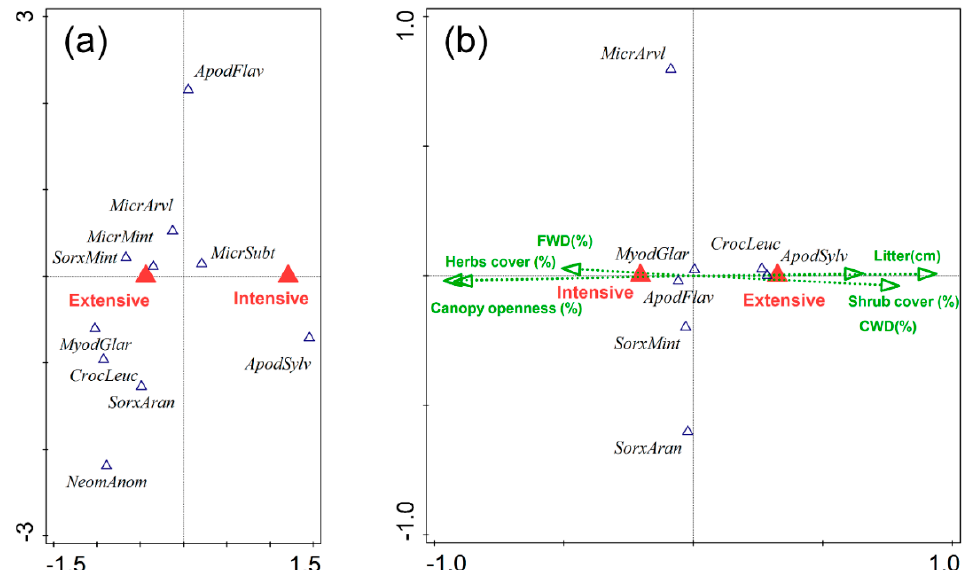
Figure 2. Partial canonical correspondence analysis biplot with the study month as a covariable showing ( a ) the change in small mammal assemblages at intensive (mechanical soil preparation after clearcutting) and extensive (without soil preparation) study plots; ( b ) di ff erences within small mammal assemblages according to di ff erent management intensity (intensive—artificial thinning; extensive—natural regeneration) in old-growth forest stands. Forest characteristic were passively projected onto the ordination diagram. ApodFlav , Apodemus flavicollis ; ApodSylv , Apodemus sylvaticus ; MicrSubt , Microtus subterraneus ; MicrArvl , Microtus arvalis ; MicrMint , Micromys minutus ; MyodGlar , Clethrionomys glareolus ; CrocLeuc , Crocidura leucodon ; NeomAnom , Neomys anomalus ; SorxAran , Sorex araneus ; SorxMint , Sorex minutus